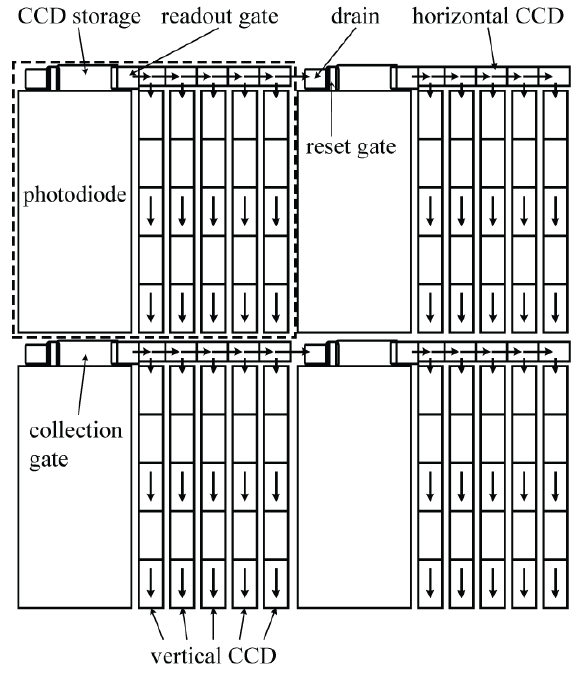
Figure 2. Burst image sensor by Kosonocky et al.